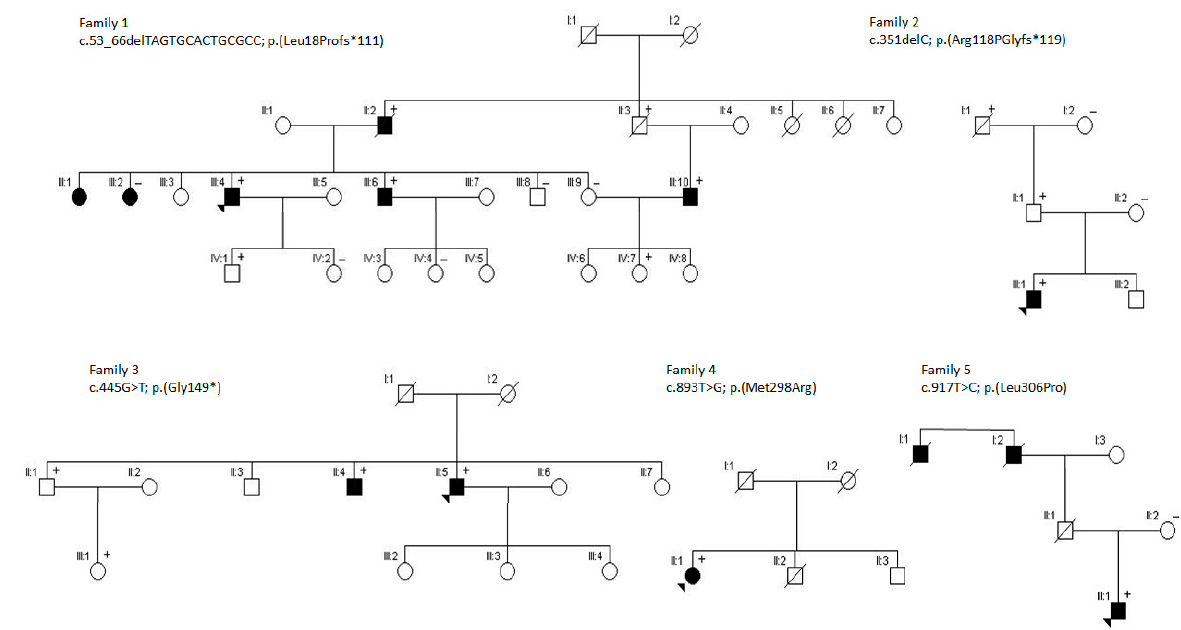
Figure 2. Pedigrees of LOX families. The probands are indicated with an arrow. Black symbols indicate family members that are affected with aortic/arterial aneurysm/dissection. Deceased individuals are indicated with a diagonal line. Plus and minus signs are used to indicate the presence and absence of the respective LOX variant.